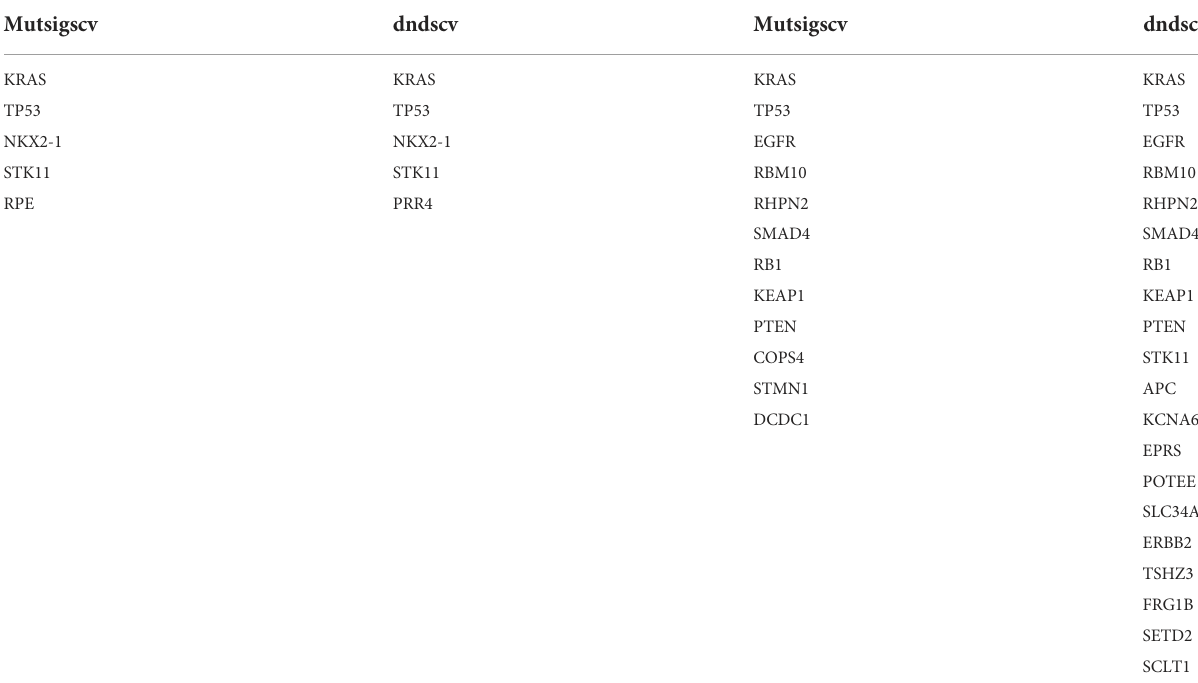
TABLE 2 Comparison of driver genes between MPA and